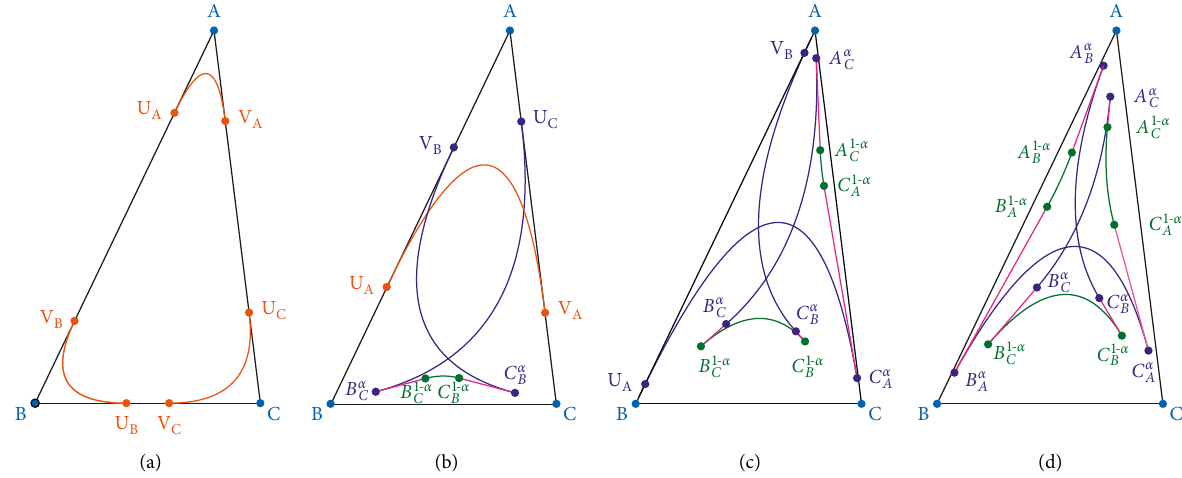
Figure 7: D for a triangle Δ ABC with a ≤ b ≤ c when (a) α ≤ a / p , (b) a / p < α ≤ b / p , (c) b / p < α ≤ c / p , and (d) c / p < α < α